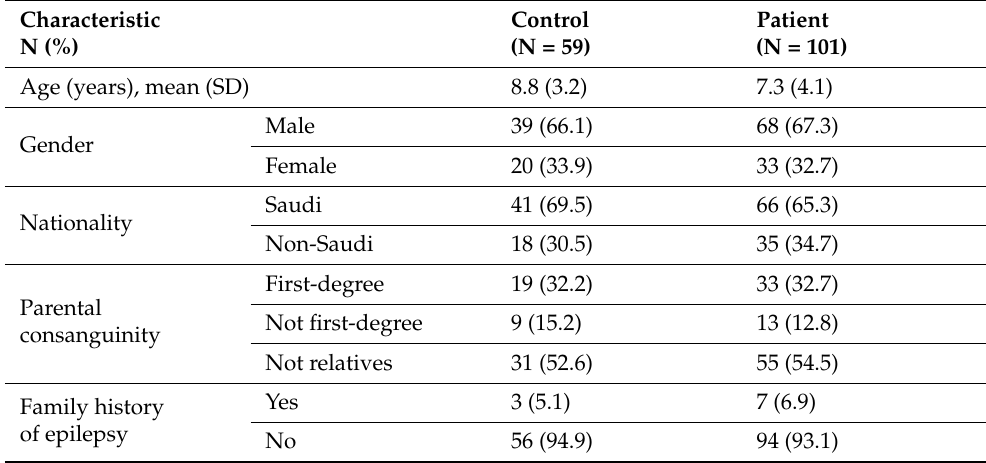
Table 2. Demographic and clinical characteristics of participants (N =